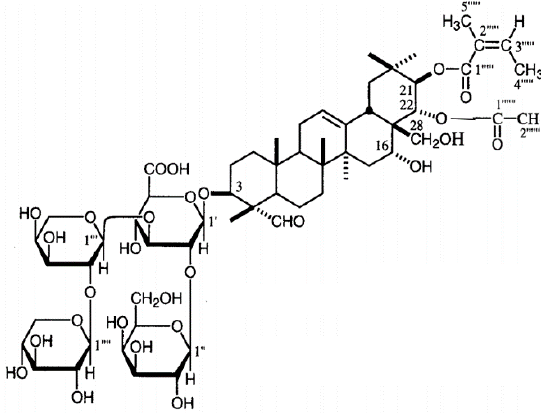
Figure 7. Chemical structure of theasaponin E 1 .